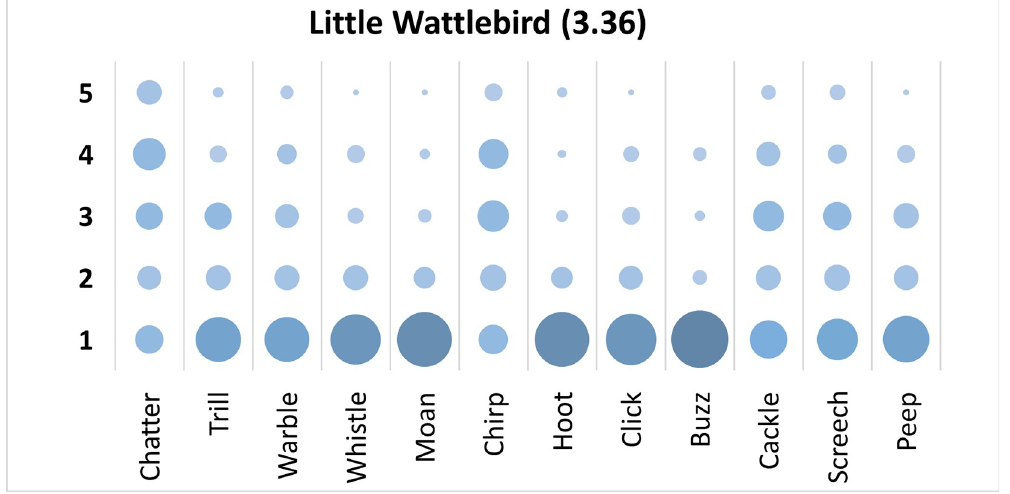
Fig 5. Count of participants’ sound descriptions scores for the Little Wattlebird with confidence ratings in brackets.